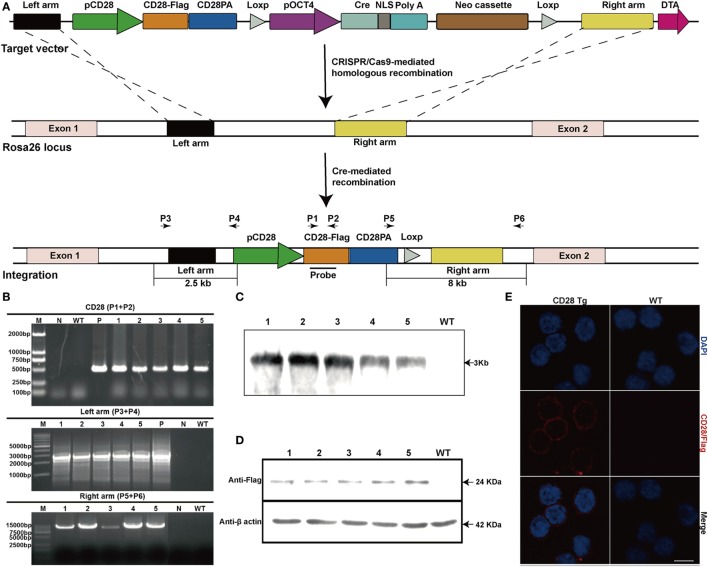
Production and identification of CD28 transgenic pigs. (A) Schematic diagram of genome editing strategy to target the Rosa26 locus in Sus scrofa via CRISPR/Cas9-mediated homologous recombination. The black arrows indicate the primers used for PCR assay (pCD28, CD28 promoter; CD28-Flag, CD28 coding sequence fused with Flag tag; CD28PA, CD28 3′ untranslated region; pOCT4, OCT4 promoter; NLS, nuclear localization sequence). (B) PCR analysis of transgenic piglets using the indicated primers (1–5, genomic DNA from transgenic piglets; N, water; P in top, plasmid pCDOCNDR used as positive control; P in middle, transgenic fibroblasts used as a positive control). (C) Southern blot analysis of transgenic pigs (WT, genomic DNA from wild-type pigs). (D) CD28-Flag expression analysis by Western blotting (1–5, five transgenic pigs; WT, wild-type pig). Data are representative of three independent Western blotting experiments. (E) Representative immunofluorescence images showing the expression of CD28-Flag on the cell membrane of peripheral blood lymphocytes from transgenic pigs. Scale bar, 5 µm.